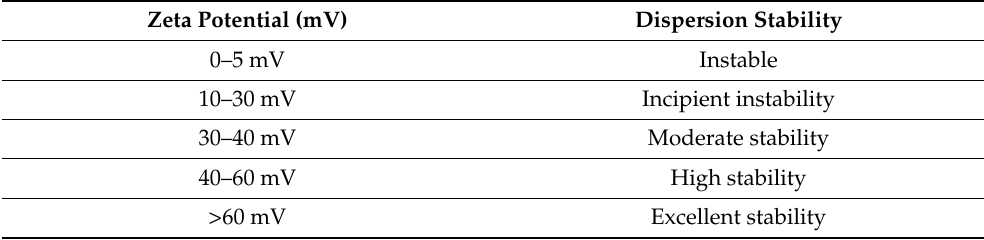
Table 2. Nanomaterials classification as a function of their dispersion stability in